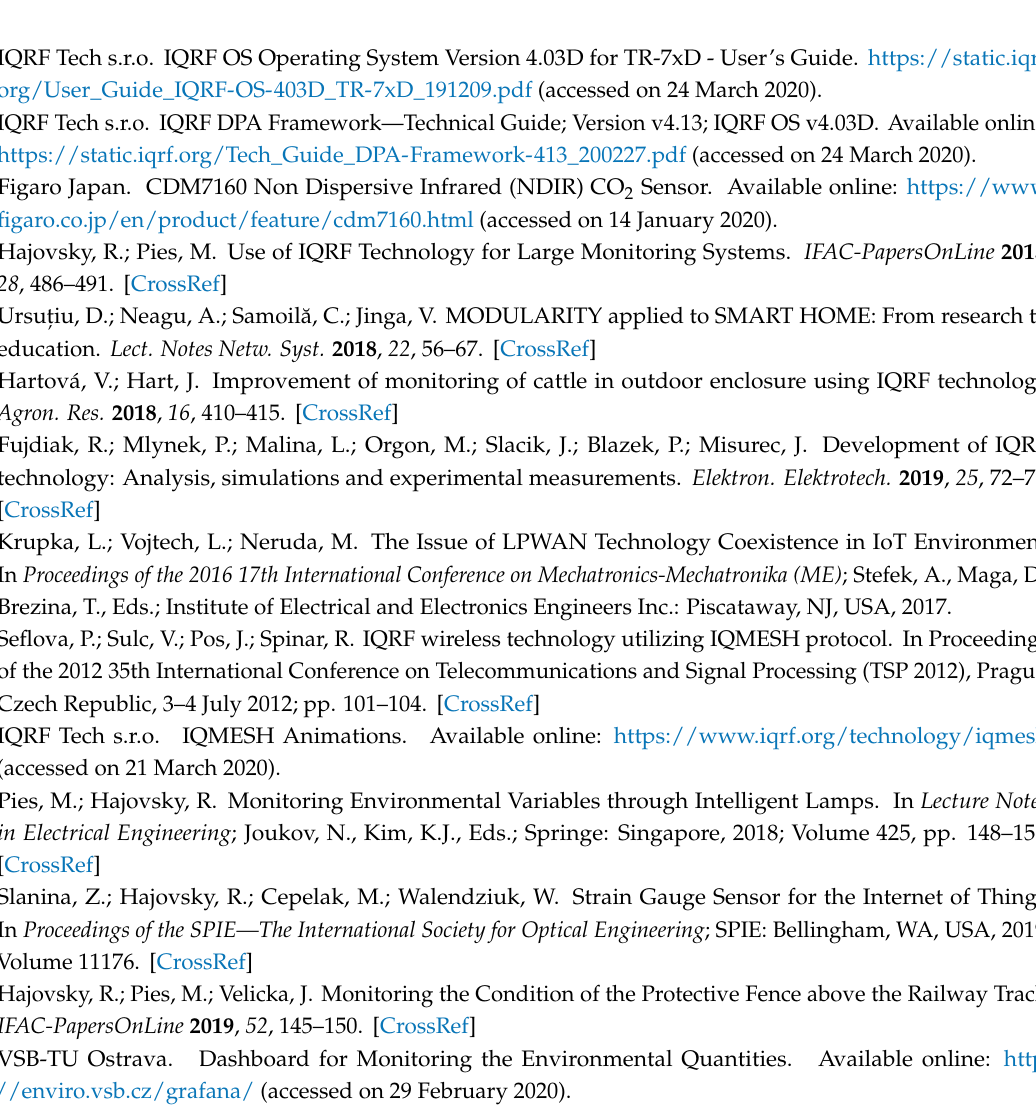
Figaro Japan. CDM7160 Non Dispersive Infrared (NDIR) CO 2 Sensor. Available online: https://www. figaro.co.jp/en/product/feature/cdm7160.html (accessed on 14 January